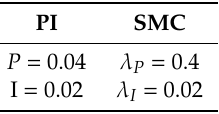
Table 1. Control gains.